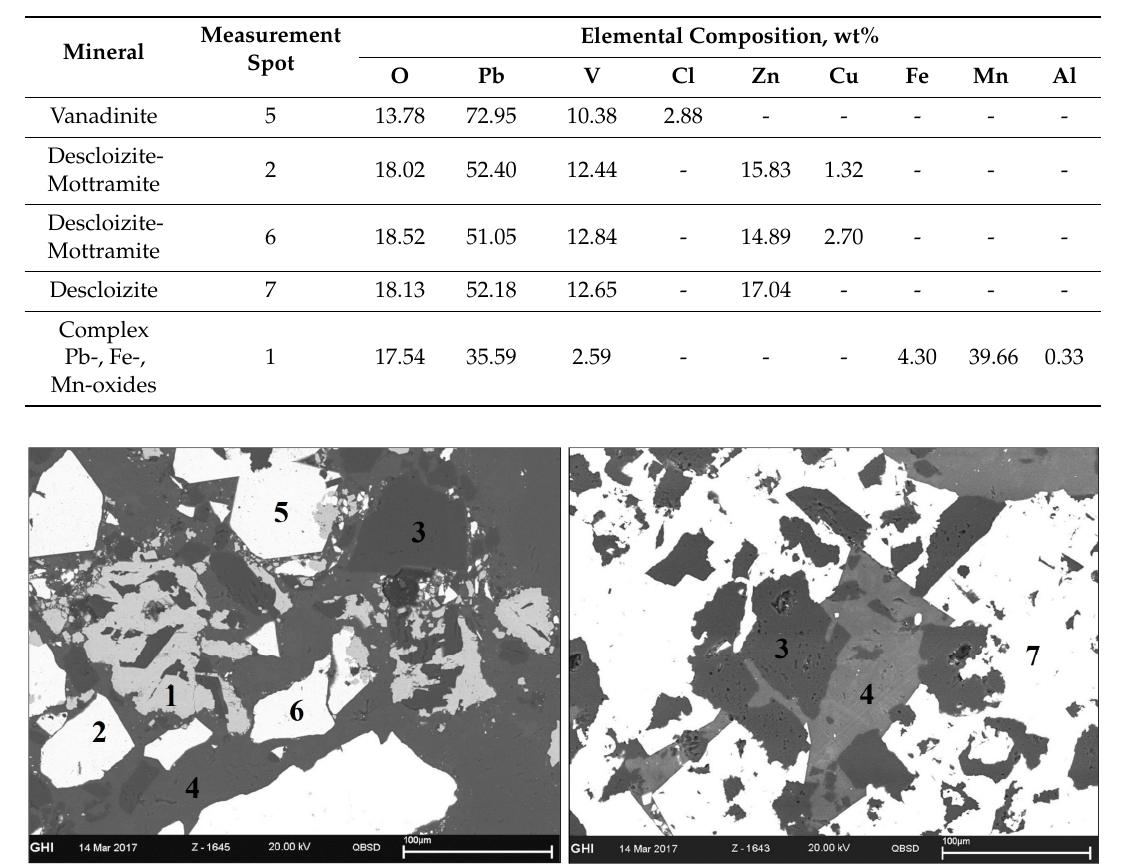
Table 3. Electron probe microanalyzer results obtained from measuring points shown in Figure 5.